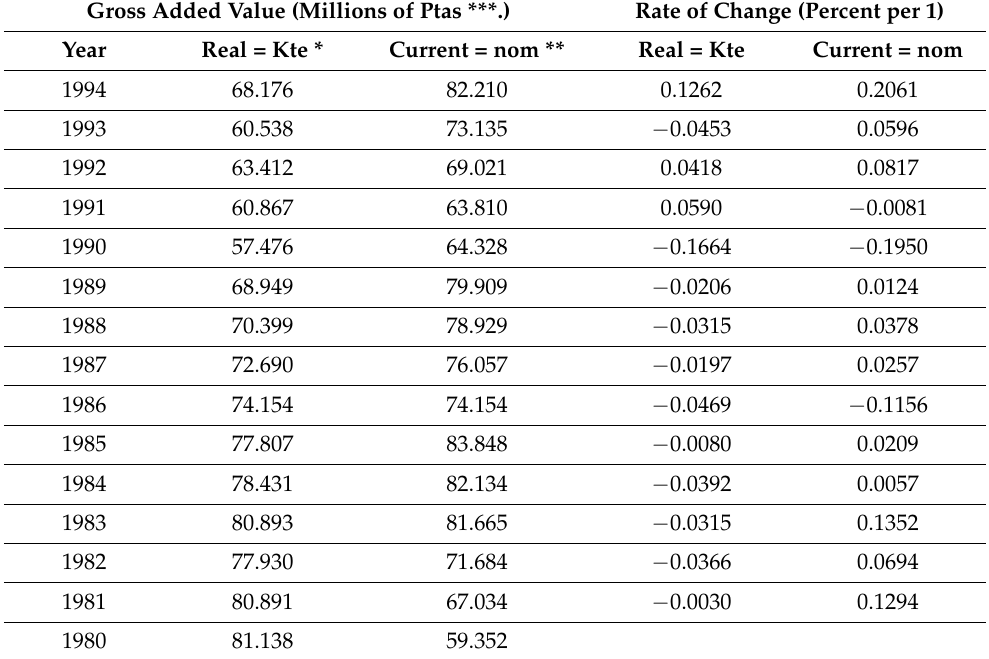
Table 4. Gross value added at market prices and variation rates in the maritime transport in Spain (1980–1994). Gross Added Value (Millions of Ptas ***.)